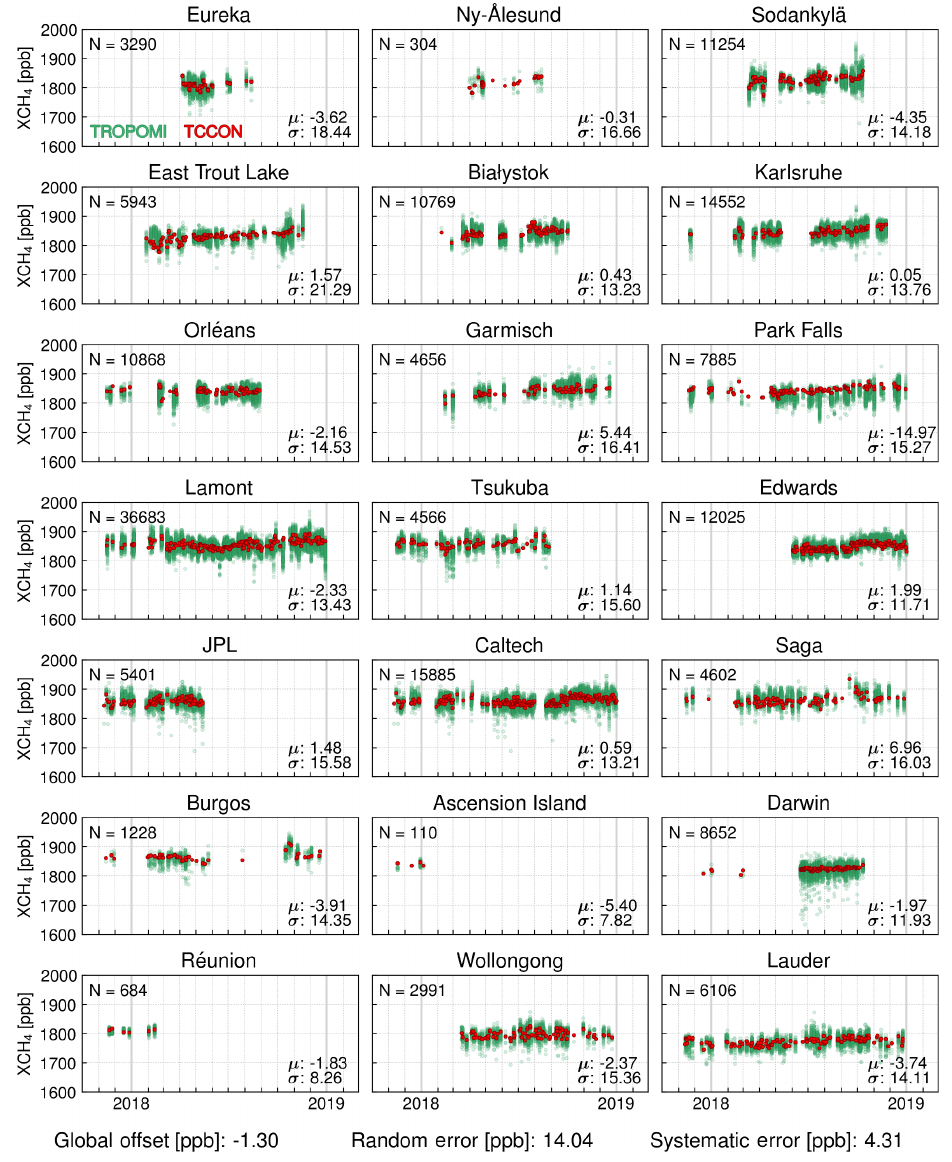
Figure 11. As Fig. 10 but for XCH 4